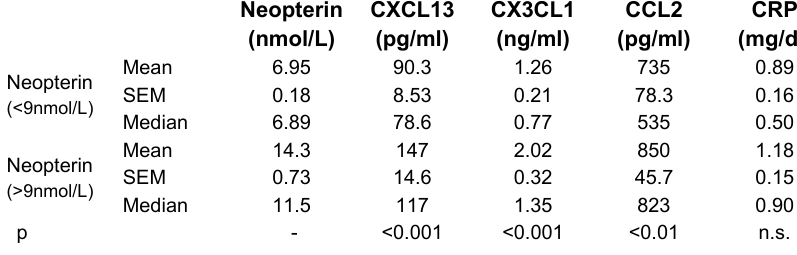
Table 4: Association between neopterin and chemo- kine concentrations in 113 patients with rheumatoid arthritis; Spearman rank correlation coefficients (r and p-values are